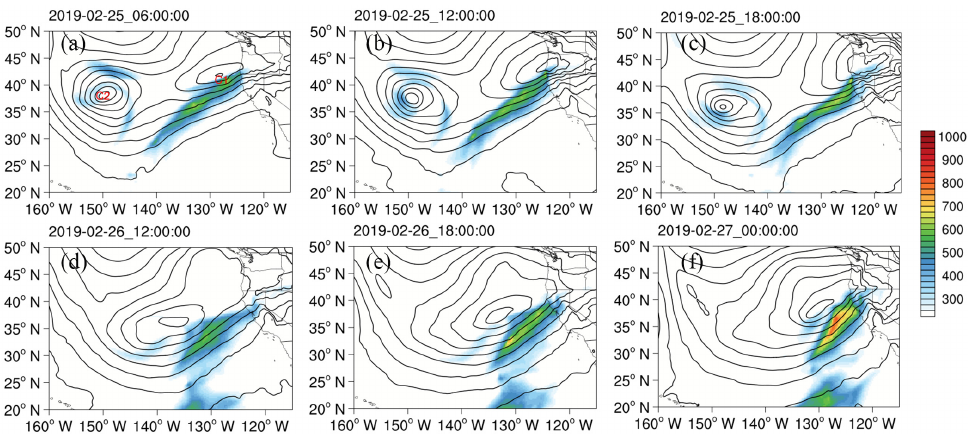
Figure 2. Maps of the 850-hPa geopotential (contours; in m 2 s − 2 ) and IVT (shadings; in kg m − 1 s − 1 ): ( a ) 25 February at 06:00 UTC, ( b ) 25 February at 12:00 UTC, ( c ) 25 February at 18:00 UTC, ( d ) 26 February at 12:00 UTC, ( e ) 26 February at 18:00 UTC and ( f ) 27 February at 00:00 UTC. The extratropical cyclones at 130° W and 150° W are respectively labeled as “C1” ad “C2” in ( a ). The difference between Stage I and Stage II is further compared in terms of rainfall